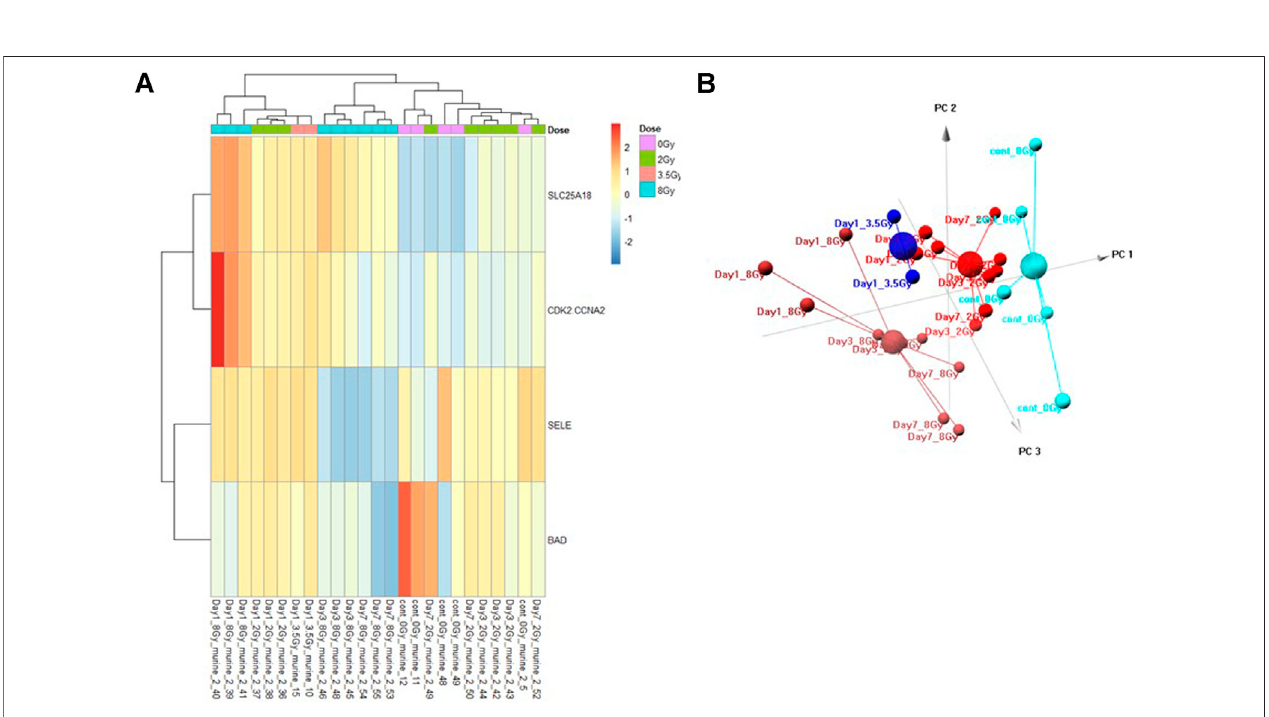
FIGURE 4 | Control vs. Dose Training Model. Analysis of proteomic expression within the sample cohort used for model building of the Control vs. Dose Training model using top selected proteins SL25A18, CDK2/CCNA2, SELE, and BAD. Findings are represented by (A) heatmap and (B) PCA.